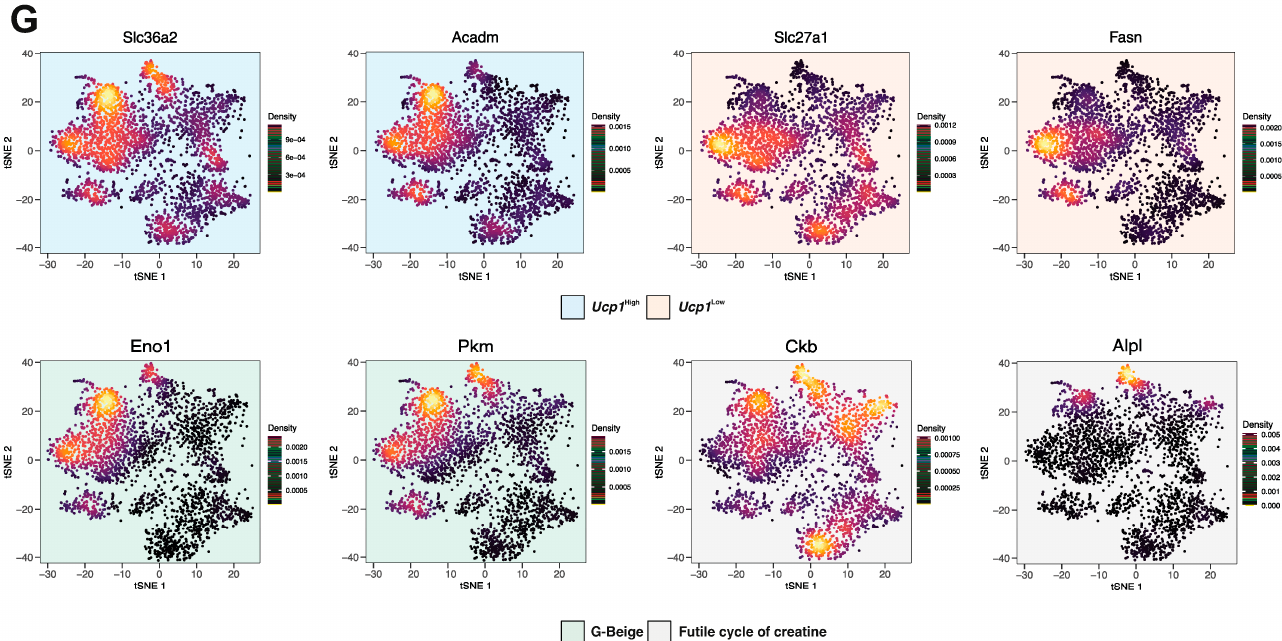
Figure 4. Ad1- Ucp1 High subpopulation shows a “classical” thermogenic profile whereas Ad1- Ucp1 Low subpopulation suggest a potential UCP1- independent pathways activation. ( A ) t -SNE representation showing Ad1, Ad2 and Ad5 mature adipocyte nuclei subclusters. The red dots represent the cells that have higher expression levels of Ucp1 . Pie charts show the corresponding percentage of high Ucp1 in each of Ad1, Ad2 and Ad5 subclusters. ( B ) Gene-expression heatmap of the top 10 most DEGs in Ad1- Ucp1 High vs. Ad1- Ucp1 Low comparison. Genes are represented in rows and cell clusters in columns. ( C ) Gene Set Enrichment Analysis (GSEA) comparing Ad1- Ucp1 High vs. Ad1- Ucp1 Low . Rows depict enriched pathways, while in y-axis the Normalized Enrichment Score (NES). A positive NES represents an upregulated pathway and negative NES represents down-regulated pathways. ( D ) Heat map showing the expression of main genes related to fatty acid oxidation, tricarboxylic acid cycle, fatty acid transport, glycolytic process, triglyceride/fatty acid cycle, and de novo lipogenesis in the Ad1- Ucp1 High and Ad1- Ucp1 Low . ( E ) Heat-scatter plot representing the top five upregulated secretome components identified in Ad1- Ucp1 High and Ad1- Ucp1 Low (upper plot). Heat-scatter plot representing the top five upregulated membranome components identified in Ad1- Ucp1 High and Ad1- Ucp1 Low (bottom plot). The color of the circles corresponds to the average logFC. ( F ) Heatmap showing the average expression for seven main TFs in Ad1- Ucp1 High cells (green background) and five main TFs in Ad1- Ucp1 Low cells (yellow background). These TFs are related to the DEGs from each comparison through the Transcription Factor Enrichment Analysis (TFEA) using the X2K database. ( G ) Nebulosa expression plots representing four positive/negative markers for Ucp1 ( Slc36a2 , Acadm , Slc27a1 and Fasn ) (on top). Nebulosa expression for G-Beige ( Eno1 and Pkm ) and Futile cycle of creatine ( Ckb and Alpl ) (bottom).